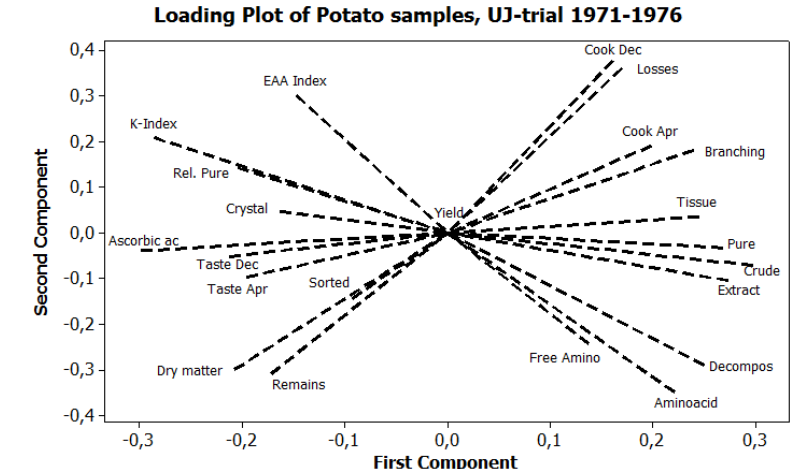
Figure 2. PCA plots on potato samples from the K- and UJ-trial. ( a ) Mean values of the 8 core variables used both in the UJ-trial and in the K-trial 1971–1979; ( b ) Mean values of the 22 variables used in the UJ-trial 1971 to